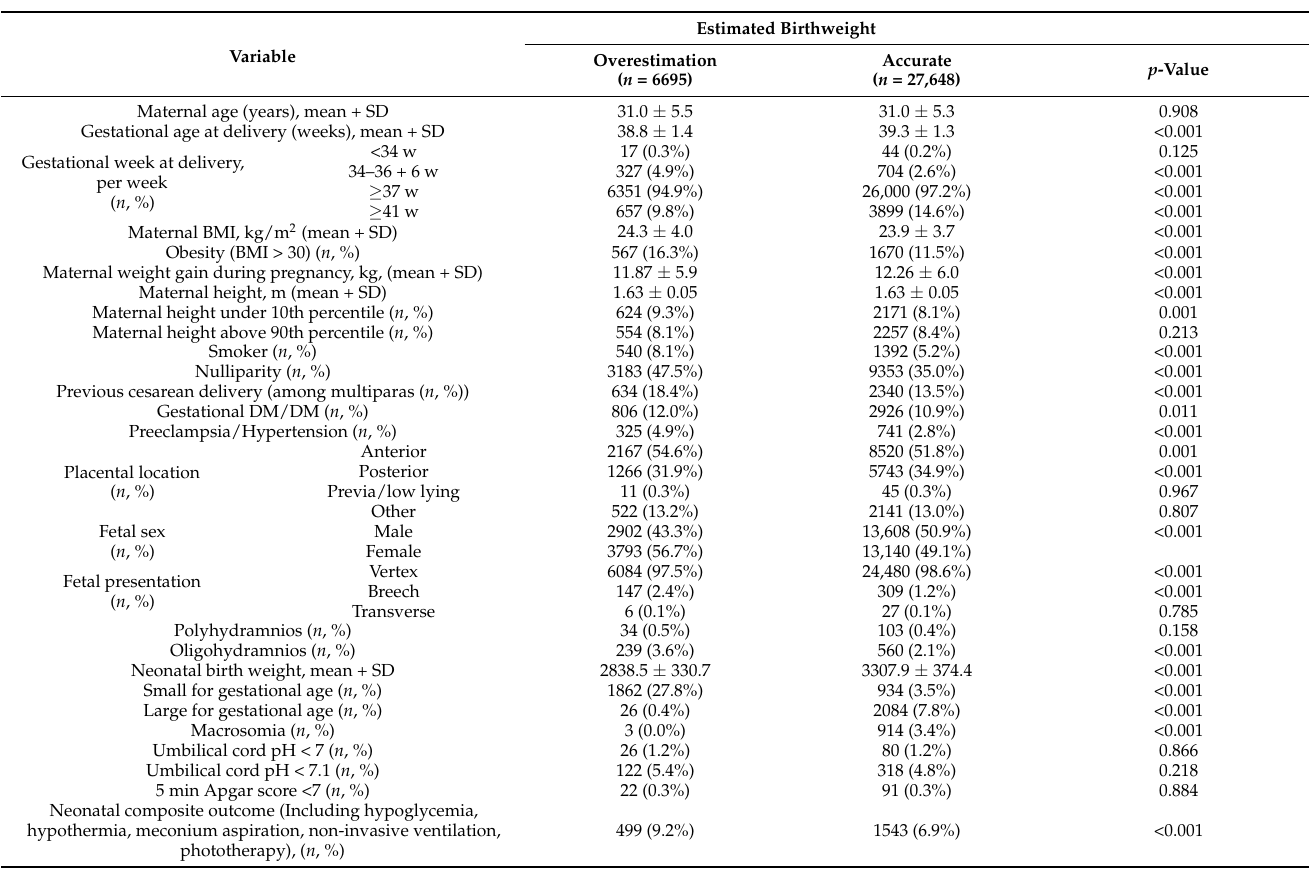
Tables 1 and 2 present the maternal, delivery and neonatal characteristics of the overestimation and underestimation groups, respectively compared to the accurate EFW group. Table 1. Maternal, delivery and neonatal characteristics of the overestimation group compared to the accurate EFW group.